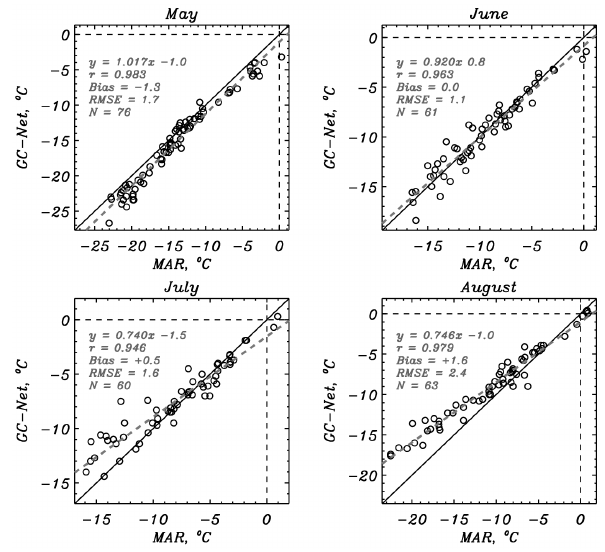
Fig. 2. Comparison of monthly averaged MAR simulations of downward shortwave irradiance with observations from GC-Net au- tomatic weather stations spanning the 2000–2010 period when GC- Net S ↓ data are available for this study.